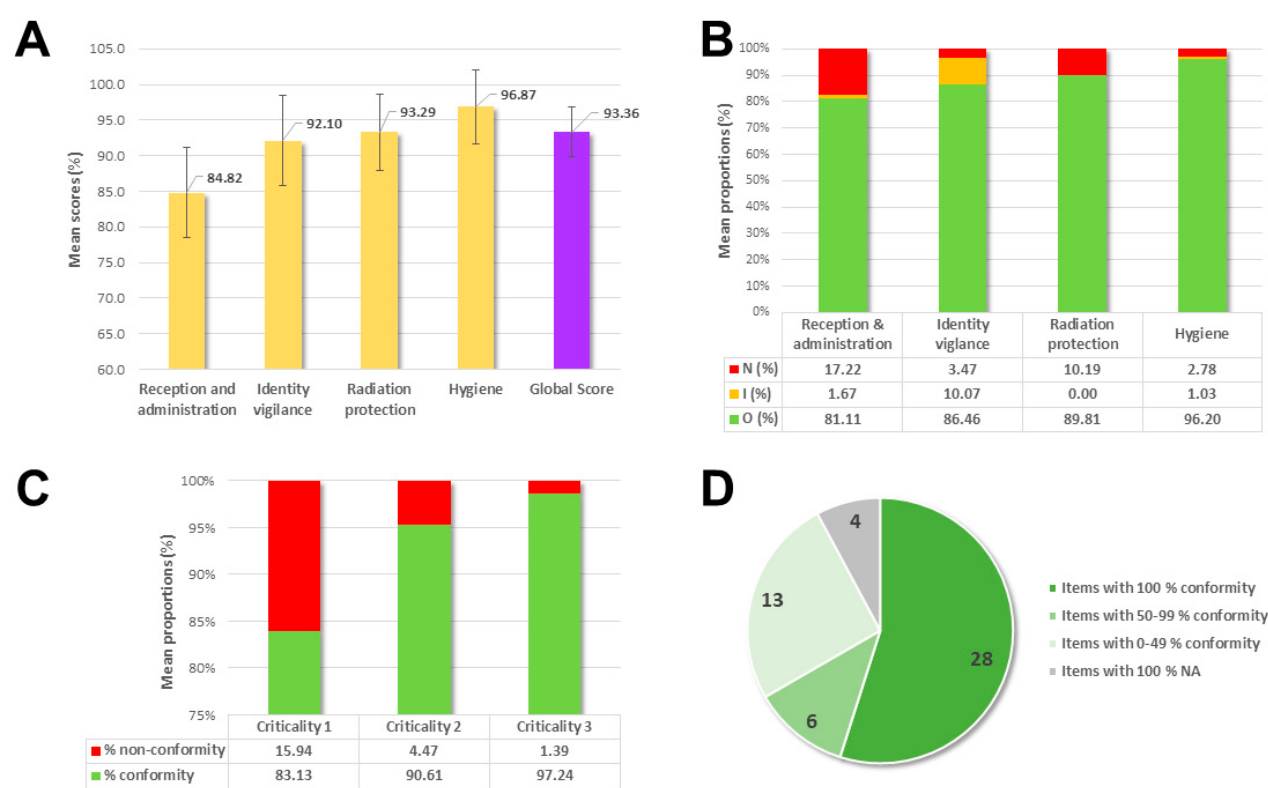
Figure 1. Results of the 36 RP injections audited during the EPP campaign with ( A ) Mean scores (%) in total and according to the themes evaluated; ( B ) Mean proportions (%) of unmet, partially met and compliant criteria based on the theme assessed; ( C ) Mean proportions (%) of conform (compliant) and non-conform (unmet or partially met) criteria depending on their criticality; ( D ) Distribution (n) of items according to their conformity rate.